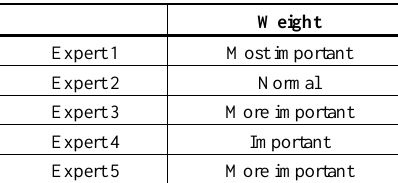
Table 6. The weights of evaluators